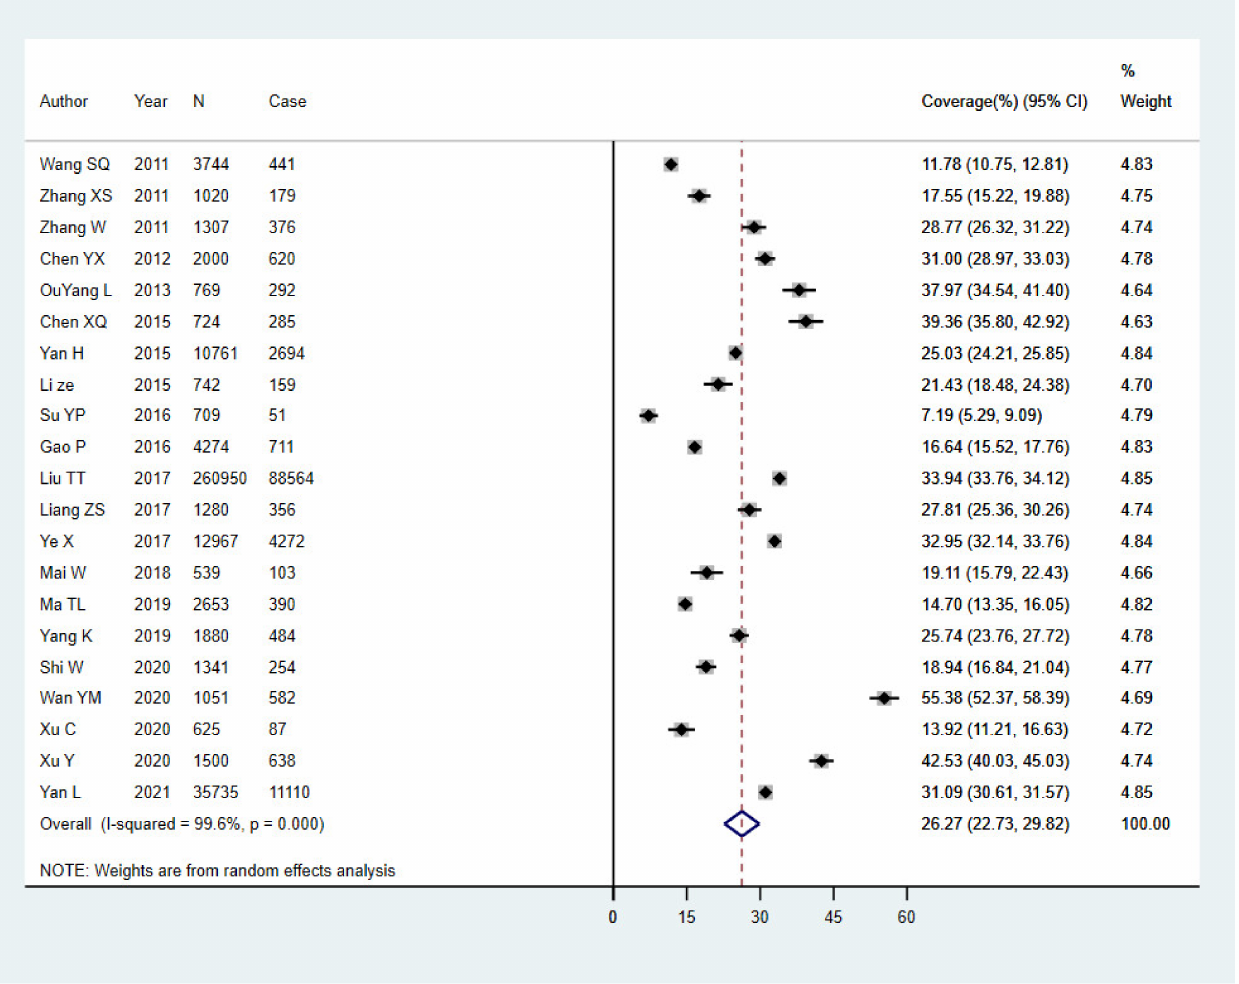
Figure 2. Forest plot of the 21 studies included in the